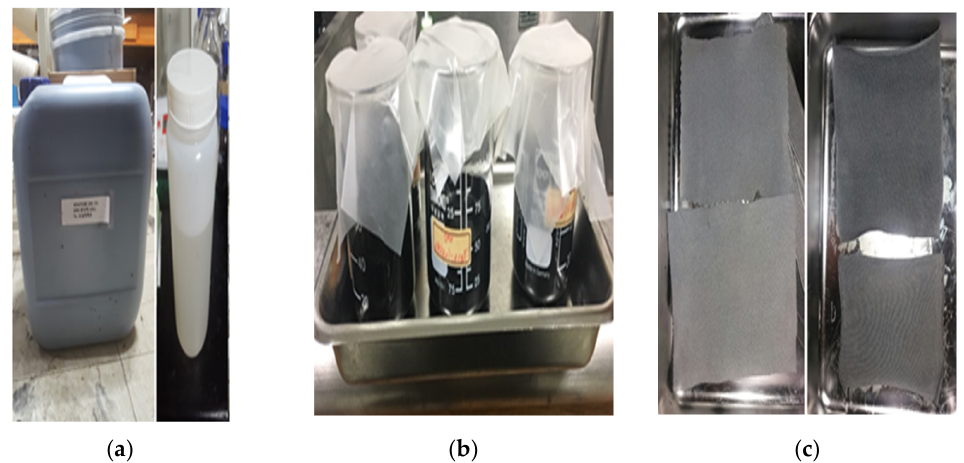
Figure 1. E-textile sensor fabrication process: ( a ) Carbon-based conductive particle fabrication. ( b ) Ink mixed with carbon solvents and dispersion stabilizers. ( c ) Fabrication of electrode and sensing parts.